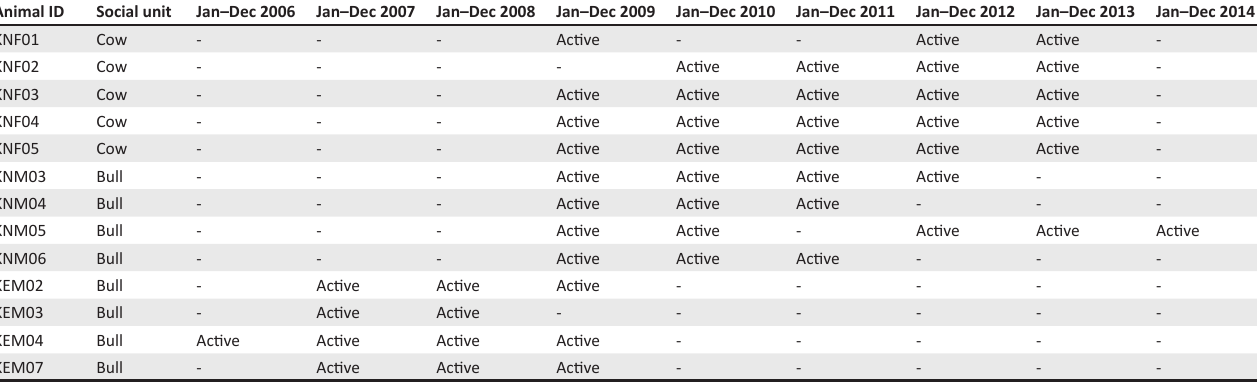
TABLE 1: Collar identification codes and the years when the collars were active for the 13 collared elephants used in this study. Animal